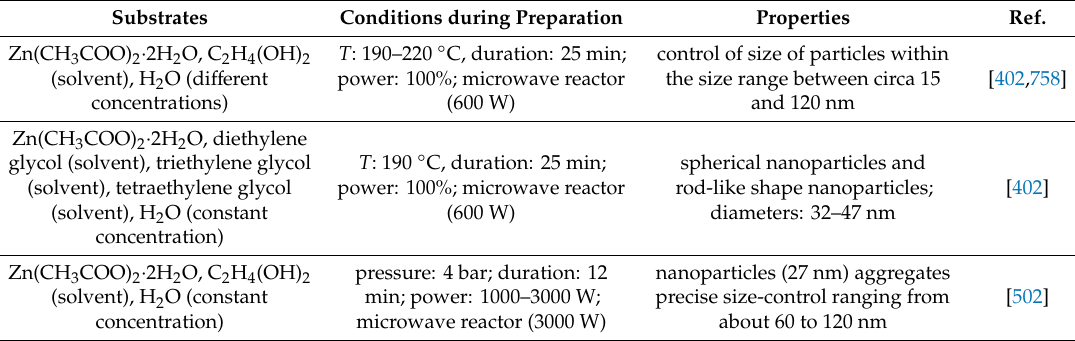
Table 10. Summary of the microwave solvothermal synthesis of ZnO without any additional heat treatment.